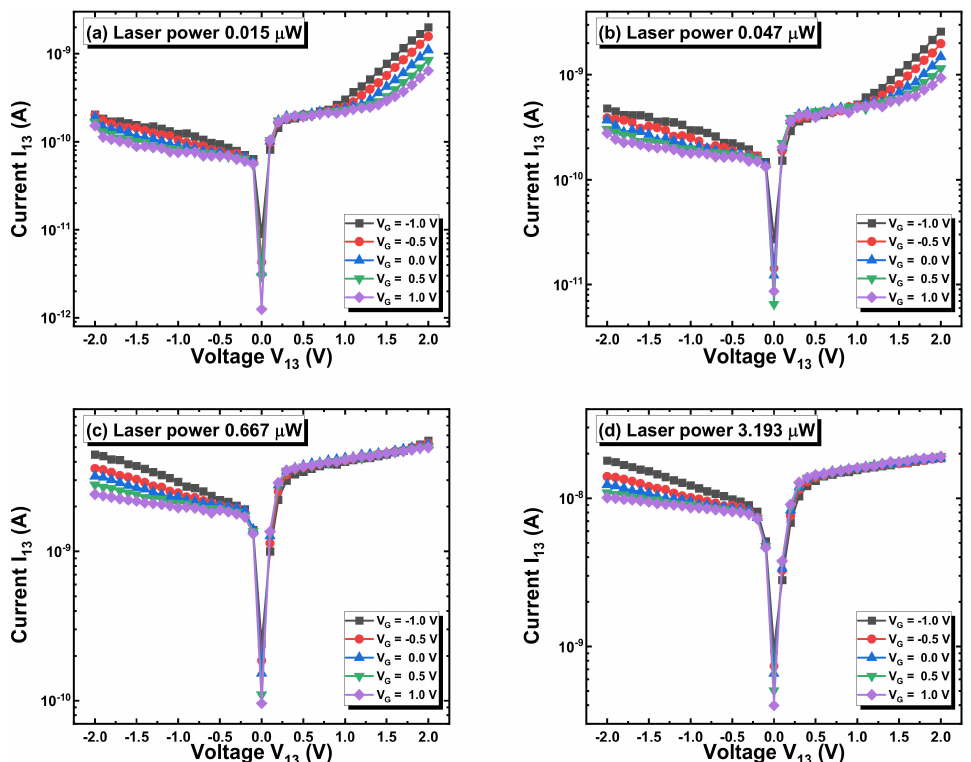
Figure 7. I–V curves in the longitudinal direction when SnSe 2 was used as the common contact at different values of gate voltage and at a laser power value of ( a ) 0.015, ( b ) 0.047, ( c ) 0.667, and ( d ) 3.193 µ W.